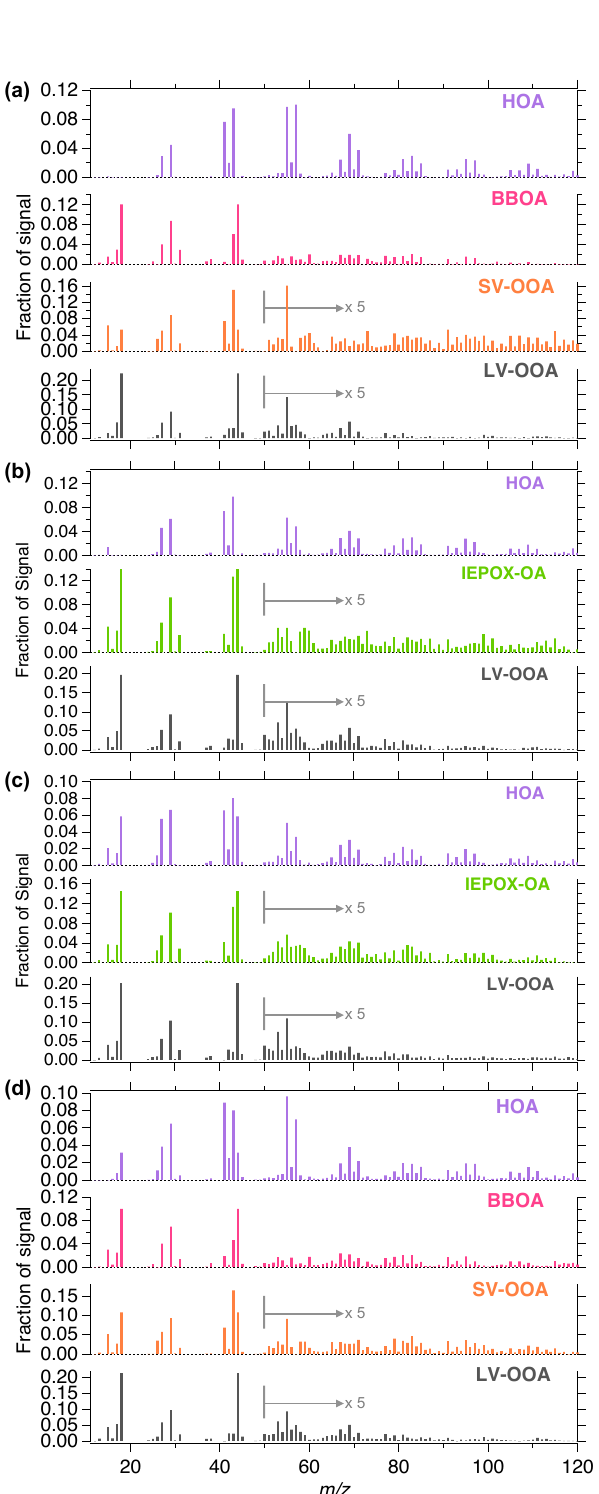
Figure 4. Mass spectra of PMF factors resolved from (a) winter, (b) spring, (c) summer and (d) fall OA measured at JST in